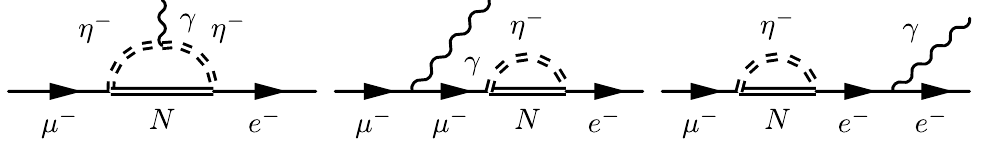
Figure 4 . Feynman diagrams contributing to the lepton (cid:13)avour violating process (cid:22) ! e(cid:13) at one loop through the exchange of Z 2 -odd right-handed neutrinos ( N ) and charged scalars ( (cid:17) (cid:0)